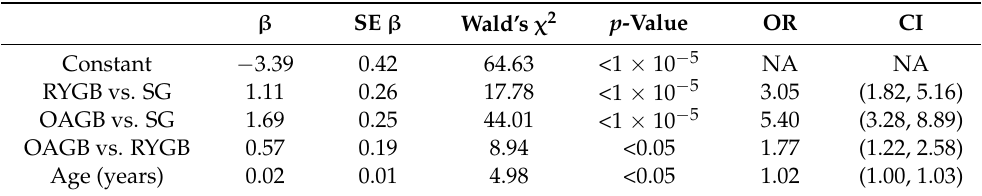
Table 3. Coefficients for variables in the logistic model of predicting abnormal ALT levels in matched population: over 33 IU/L for males, over 25 IU/L for females. β SE β Wald’s χ 2 p -Value OR